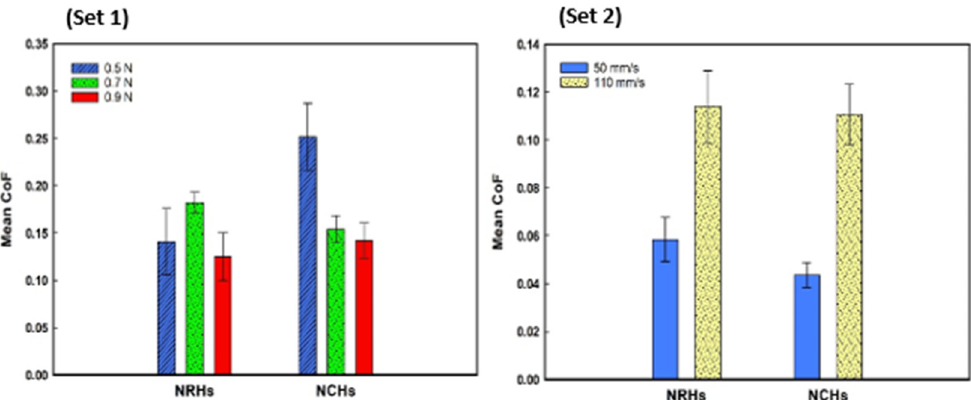
Figure 4. Mean values of the coefficient of friction for NRHs and NCHs samples in dry condition versus (set 1) applied load (Vc = 80 mm/s), and (set 2) sliding speed (Fc = 0.7 N) in dry condition, (n= 3 ± SD).